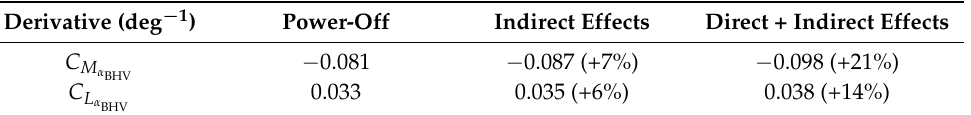
Table 8. Breakdown of direct and indirect propulsive effects on lift and pitching moment coefficient curve slope, BHV aircraft configuration, experimental results, Re = 315,000, 8750 RPM (IU), X CG at LE MAC.